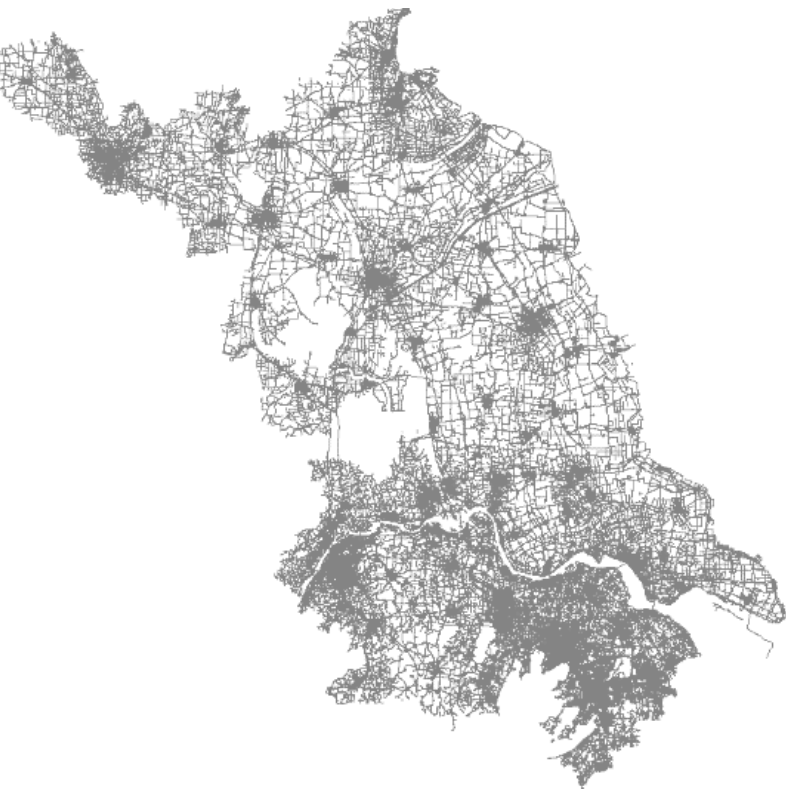
Figure 6. Road network in Jiangsu Province.